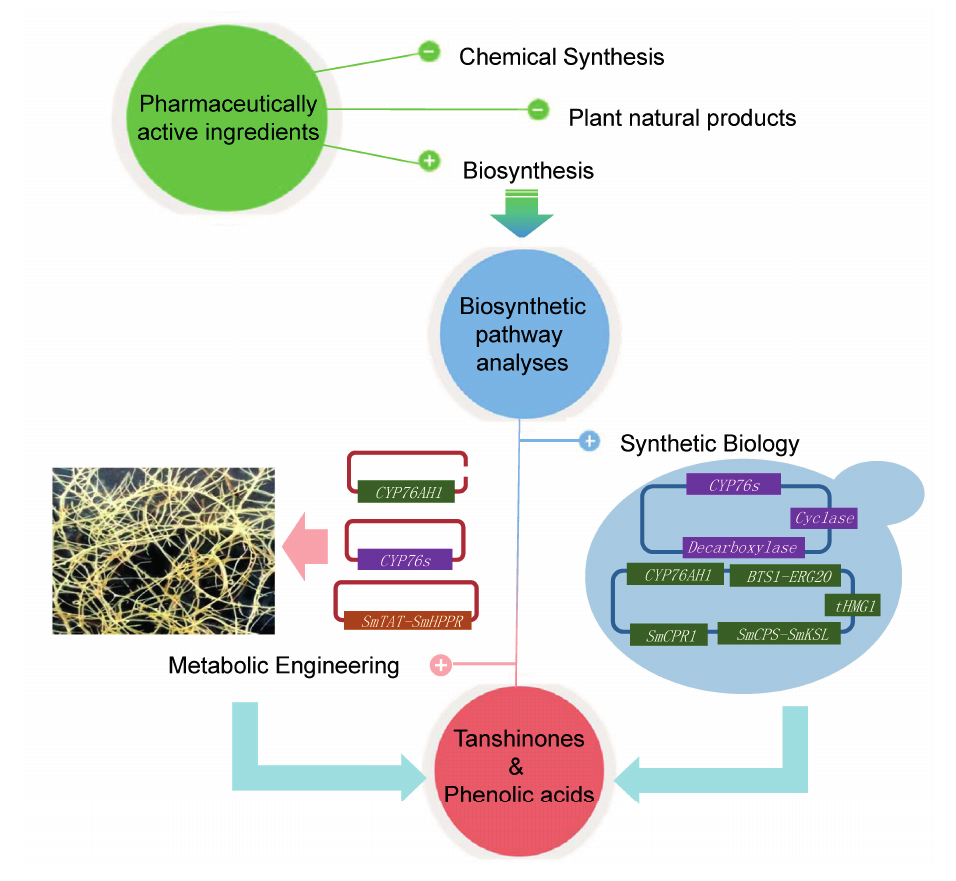
Figure 3. Biotechnogical applications in Salvia